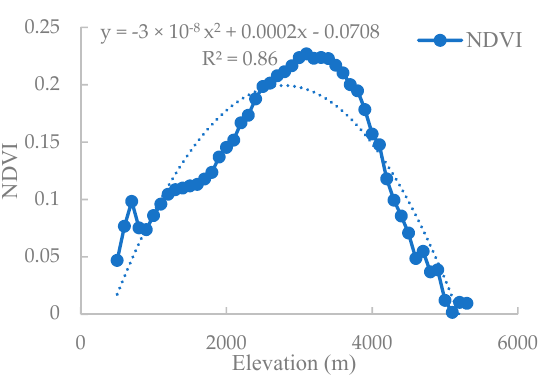
Figure 8. Relationship between vegetation damage and elevation.